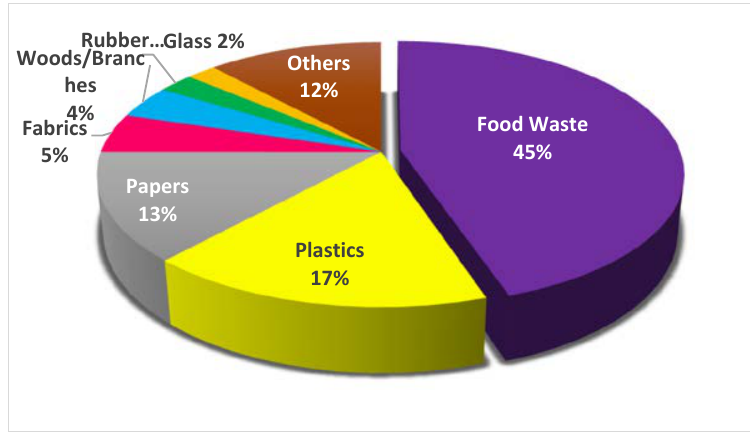
Fig. 2: Waste Composition in Bandung City, West Java, Indonesia (SIPSN, 2022